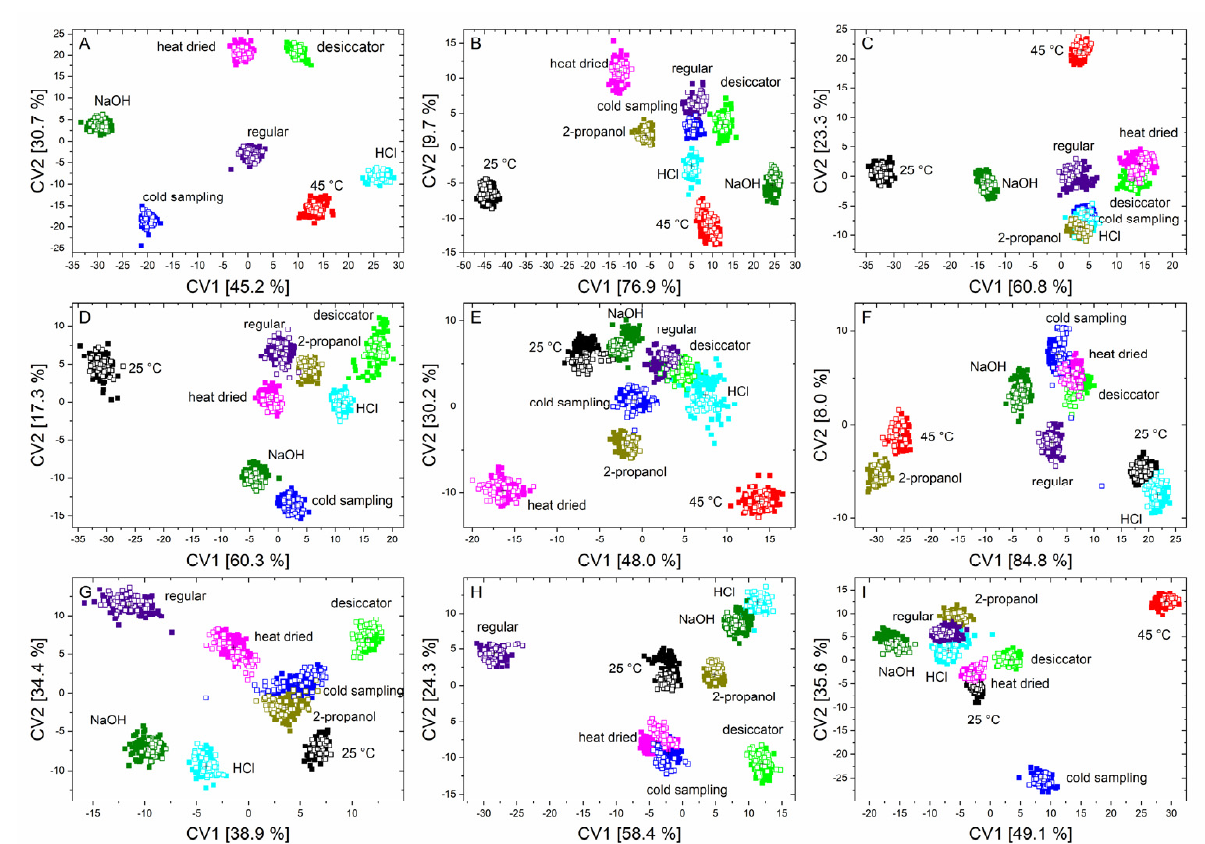
Figure 4. Scatter plots of canonical variable one and two of the QDA of the training data (solid squares) and the independent test data (unfilled squares) of B. coag ( A ), B. sub ( B ), B. therm ( C ), B. tii ( D ), E. coli K12 ( E ), M. luteus ( F ), Ps. fluor 4358 ( G ), Ps. fluor 50090 ( H ) and E. coli TOP10 ( I ) to discriminate all nine conditions.